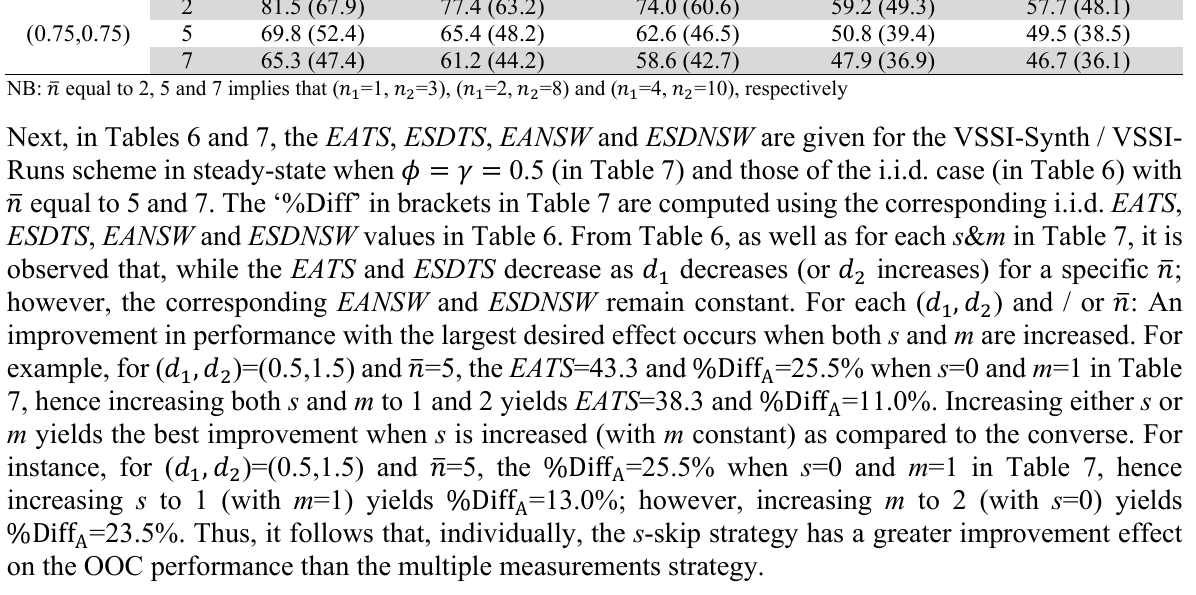
The EATS (first row), ESDTS (second row), EANSW (third row) and ESDNSW (fourth row) for the steady- state VSSI-Synth and VSSI-Runs 𝑋(cid:3364) scheme when H =5, 𝑛(cid:3364) ∈ {5, 7}, 𝑑̅ =1, 𝜙 = 𝛾 = 0 and ATS 0 =370.4 𝑛(cid:3364)